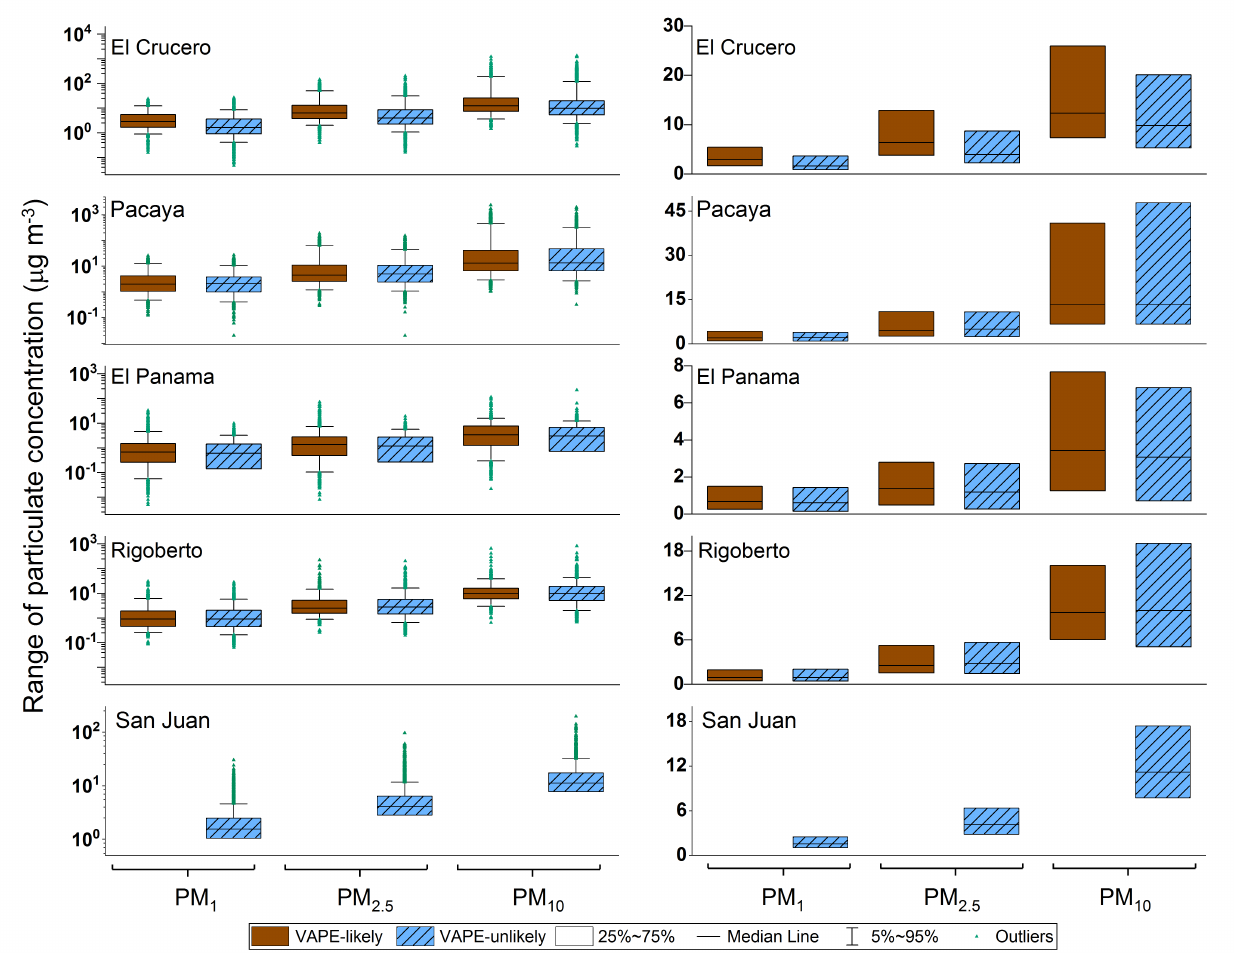
Figure 12: Range of PM concentrations at El Crucero, Pacaya, El Panama, Rigoberto, and San Juan measurement stations under VAPE-likely (brown box-plots) and VAPE-unlikely (blue box-plots) conditions. Note the logarithmic y-axis scale on the left-hand graphs and linear y-axis scale on the right-hand graphs. VAPE-likely or VAPE-unlikely conditions are as identified by ECWMF forecasts and satellite imagery. Data plotted are hourly averages across the entire measurement